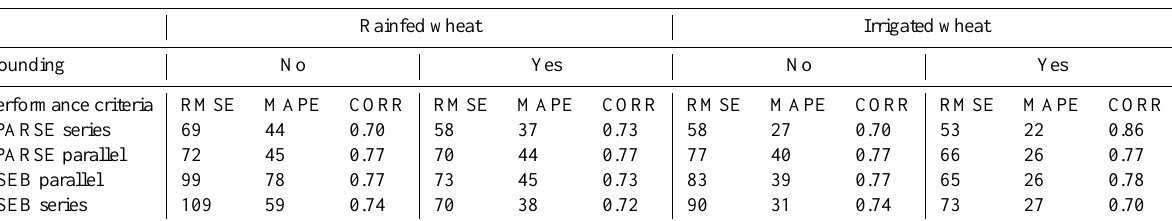
Table 1. Performances of instantaneous latent heat flux retrieval at midday (RMSE: root mean square error in Wm − 2 ; MAPE: mean absolute percentage error in %; CORR: correlation coefficient).